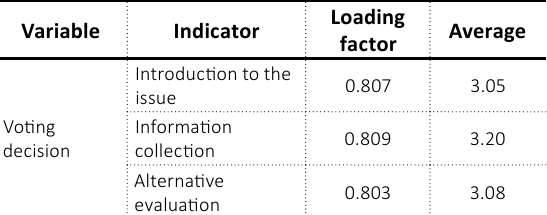
Table 3. The results of evaluation of outer model